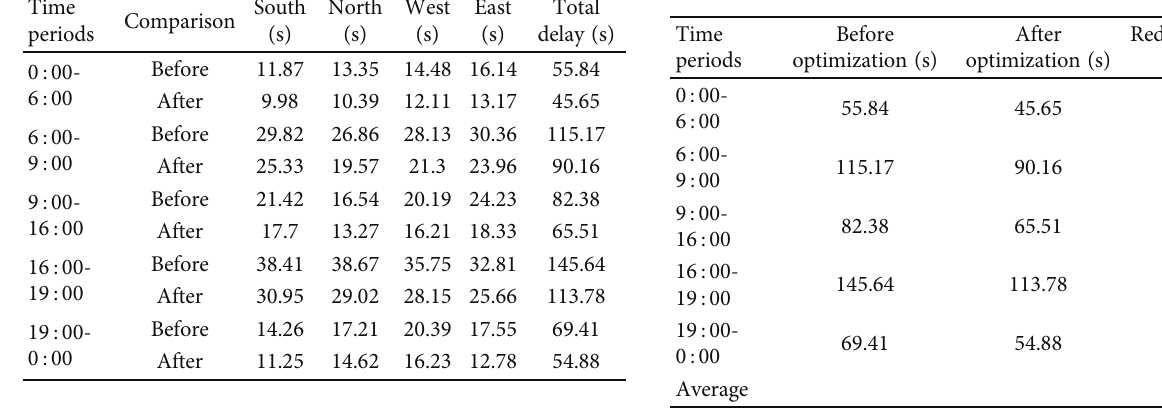
Figure 5: Screenshot of Table 7: Comparison of simulation result between before and after optimization.